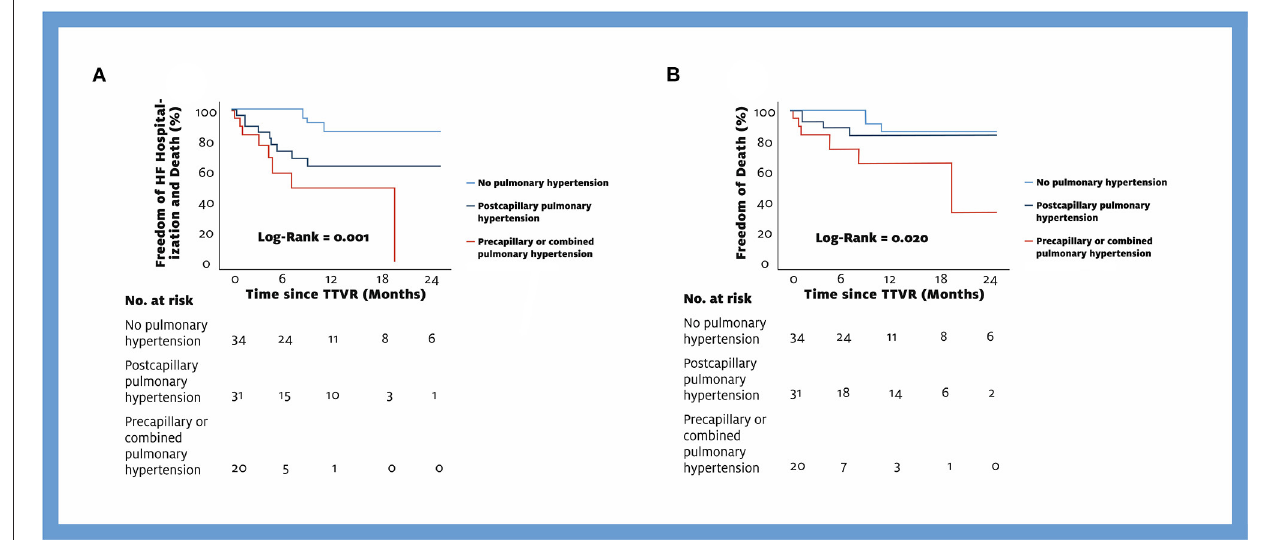
FIGURE 4 | Kaplan-Meier Curves for the endpoints Death and HF hospitalization (A) and Death (B) by different PH groups. TTVR, transcatheter tricuspid valve repair; HF, heart